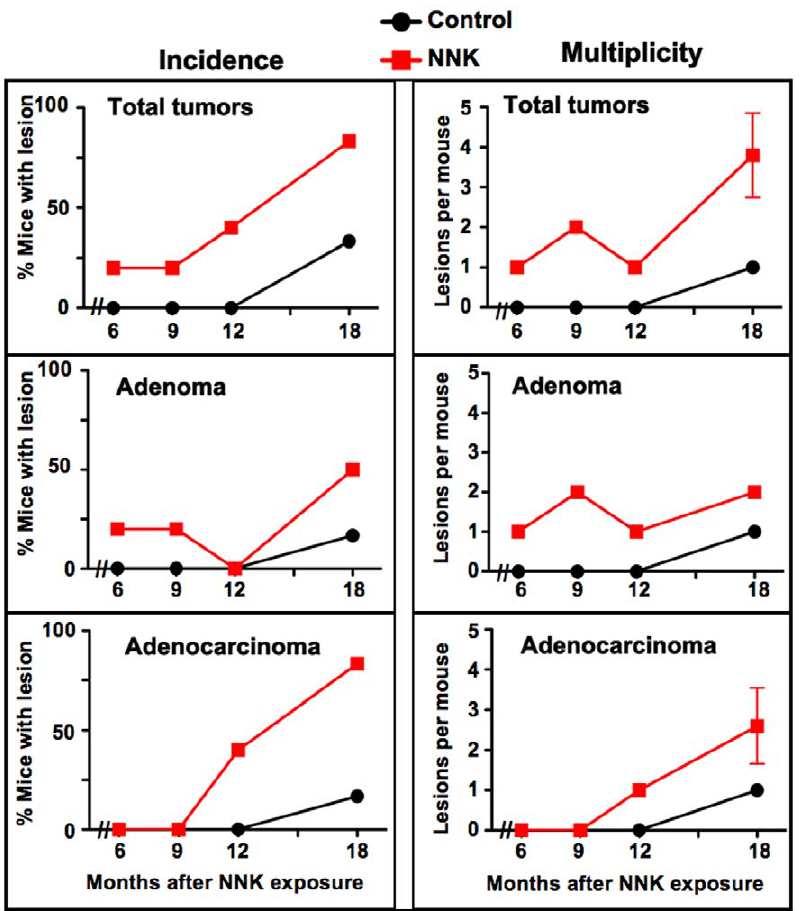
Figure 2. Increased incidence and multiplicity of lung tumors in Gprc5a -knockout mice exposed to NNK compared to control mice. Graphs depicting the percentage of mice with lung tumors (left panels) and number of tumors per mouse as a measure of multiplicity (right panels) in the control (orange line) and NNK-exposed (black line) groups at 6, 9, 12 and 18 months following injection with the carcinogen.